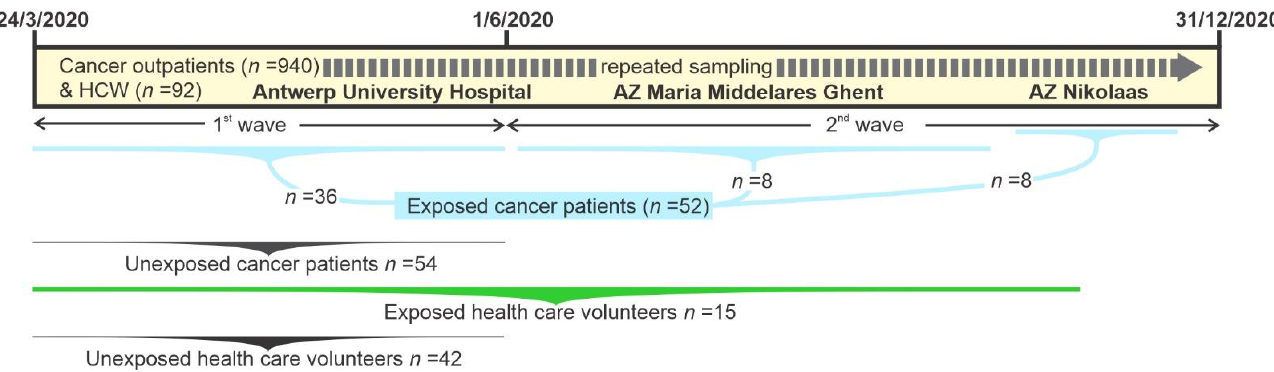
Figure 1. Study design. Cancer outpatients were enrolled and additional blood samples were taken with every clinically indicated blood draw. SARS-CoV-2 exposure was tested and patients were divided in groups accordingly, where unexposed patients and health care workers were matched with the exposed ones. HCW , health care workers.